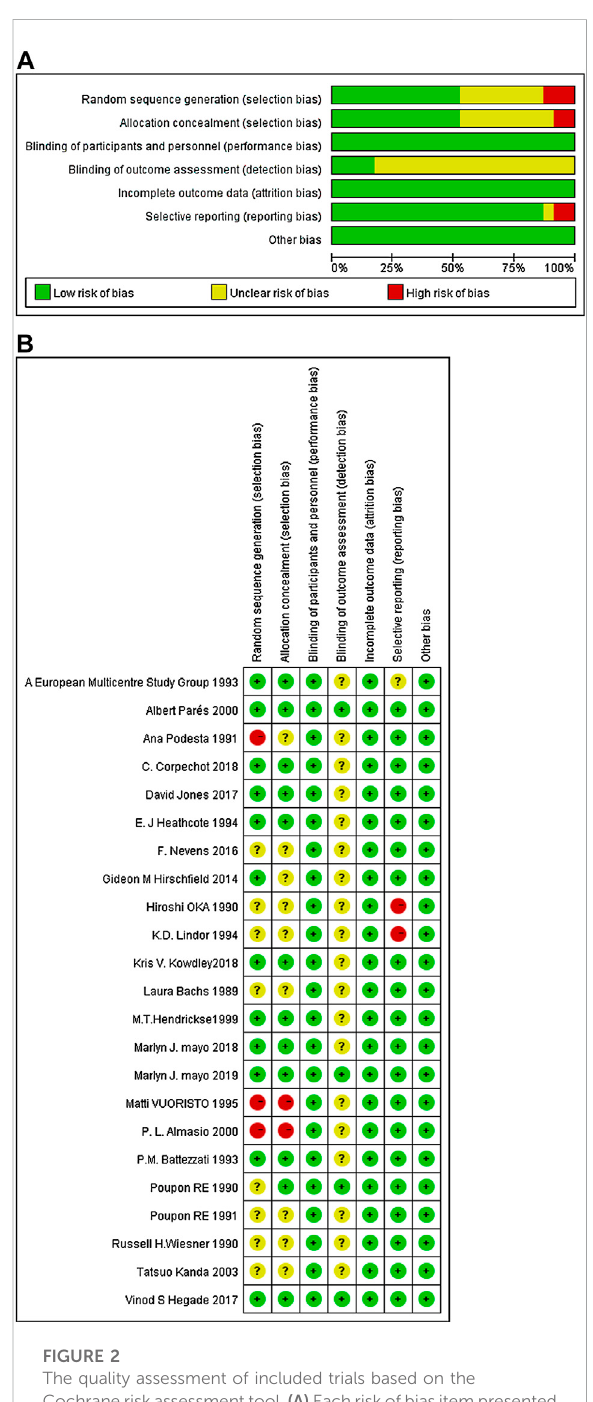
FIGURE 2 The quality assessment of included trials based on the Cochraneriskassessmenttool. (A) Eachriskofbiasitem presented aspercentagesacrossallincludedstudies; (B) Eachriskofbiasitem for each included